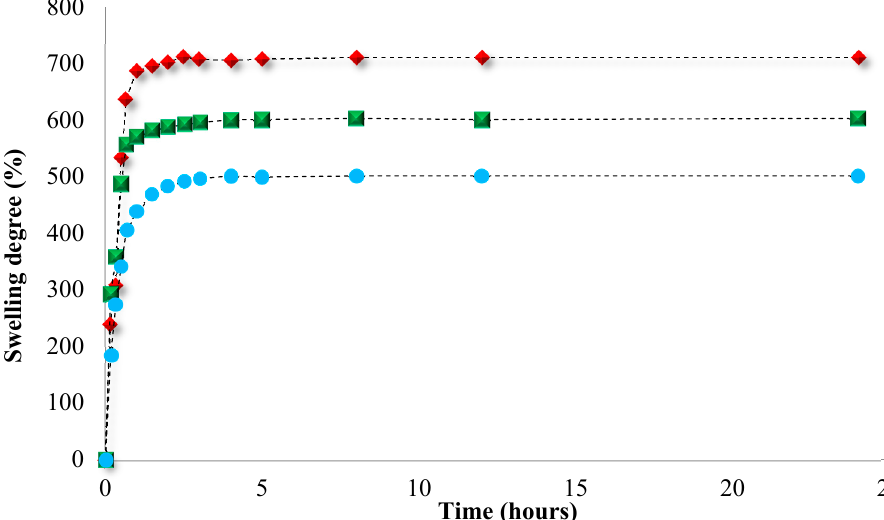
Figure 1. Swelling kinetics curves of the PNVP-based NPs in alkaline conditions (pH = 7.4). Circles—NPs3; Squares—NPs2; Diamonds—NPs1.